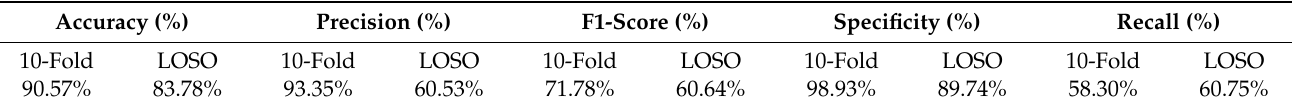
Table 4. LOSO and 10-Fold results for final binary classification.